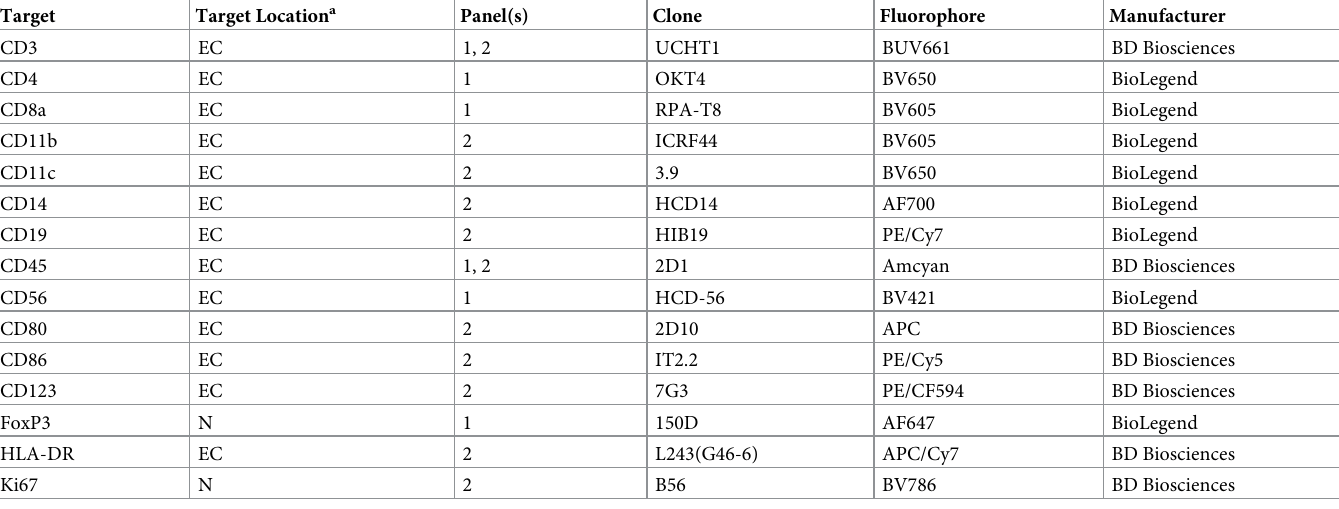
Table 2. Antibodies Used in Flow Cytometry Analysis of Tissues from Hu-NSG Mice Bitten by Ae . aegypti Mosquitoes.